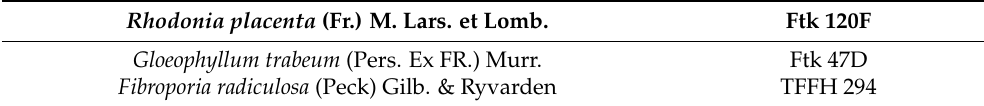
Table 4. Fungi strain used for the brown rot resistance test. Rhodonia placenta (Fr.) M. Lars. et